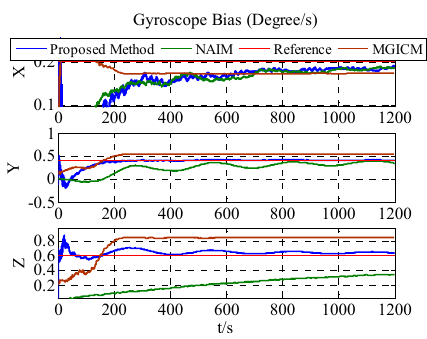
Figure 8 . Estimation result of gyroscope bias. Figure 8. Estimation result of gyroscope